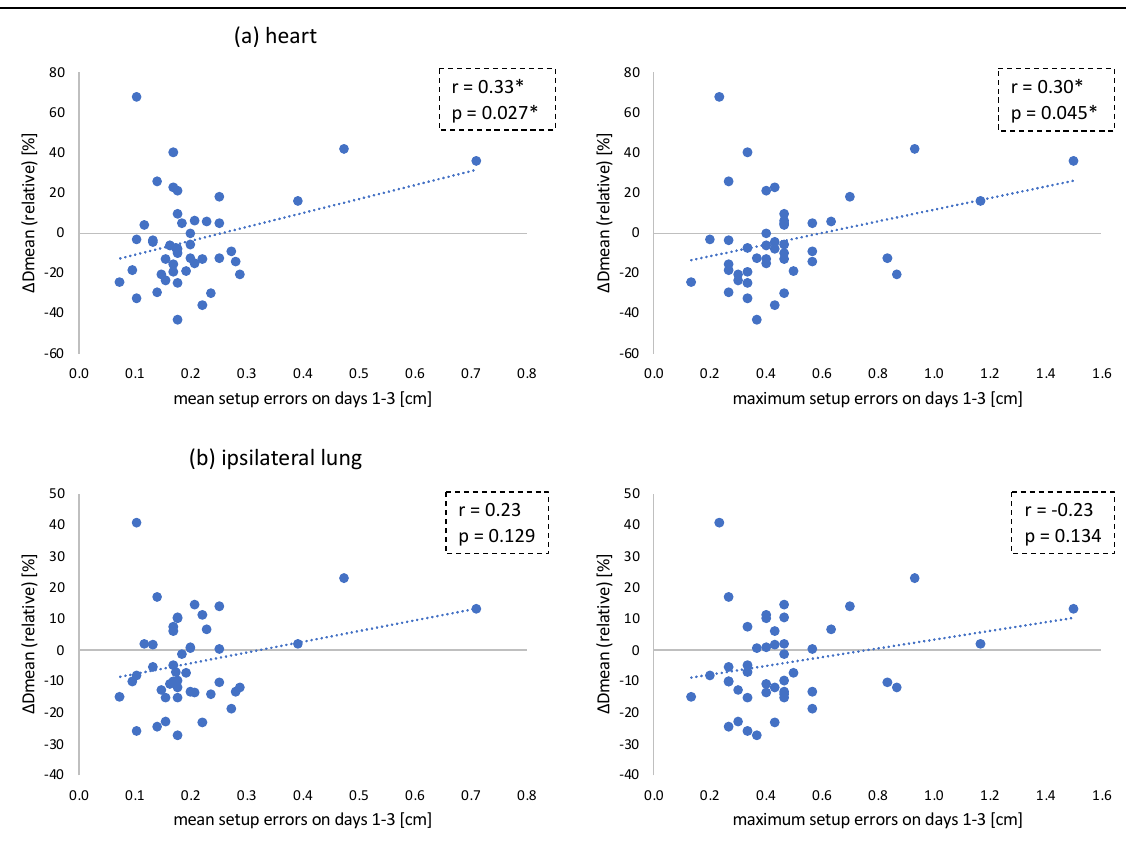
3.3. Correlation of Setup Errors on Days 1–3 and OAR Dose Exposure For heart and LAD, no significant correlation was found between dose exposure (Dmean) and mean setup errors in lateral and CC dimension. A moderate correlation was found between dose exposure and mean setup errors in AP and any dimension. Accordingly, no significant correlation was found between dose exposure and maximum setup errors in lateral and CC dimension, whilst a moderate correlation was found between dose exposure and maximum setup errors in AP and any dimension. For ipsilateral lung and contralateral breast, no significant correlation was found between dose exposure and setup errors. The relation between OAR exposure and setup errors on days 1–3 is illustrated in Figure 5. Product moment correlation coefficients and the respective p -values are summarized in Table 2.